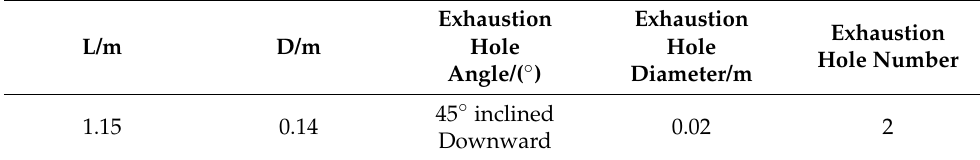
Table 1. Size parameters of SUBOFF